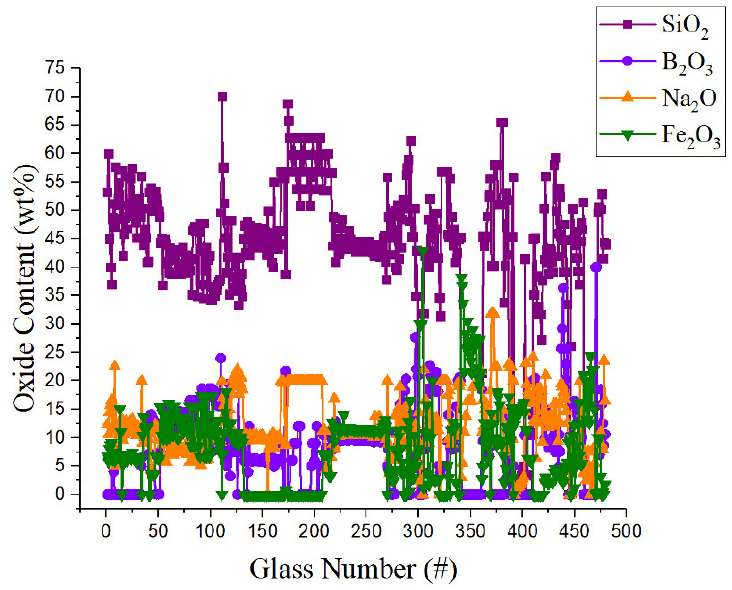
Figure 1. Content distribution of the main oxides in the glasses, namely SiO 2 , B 2 O 3 , Na 2 O, and Fe 2 O 3 in 479 compositions.